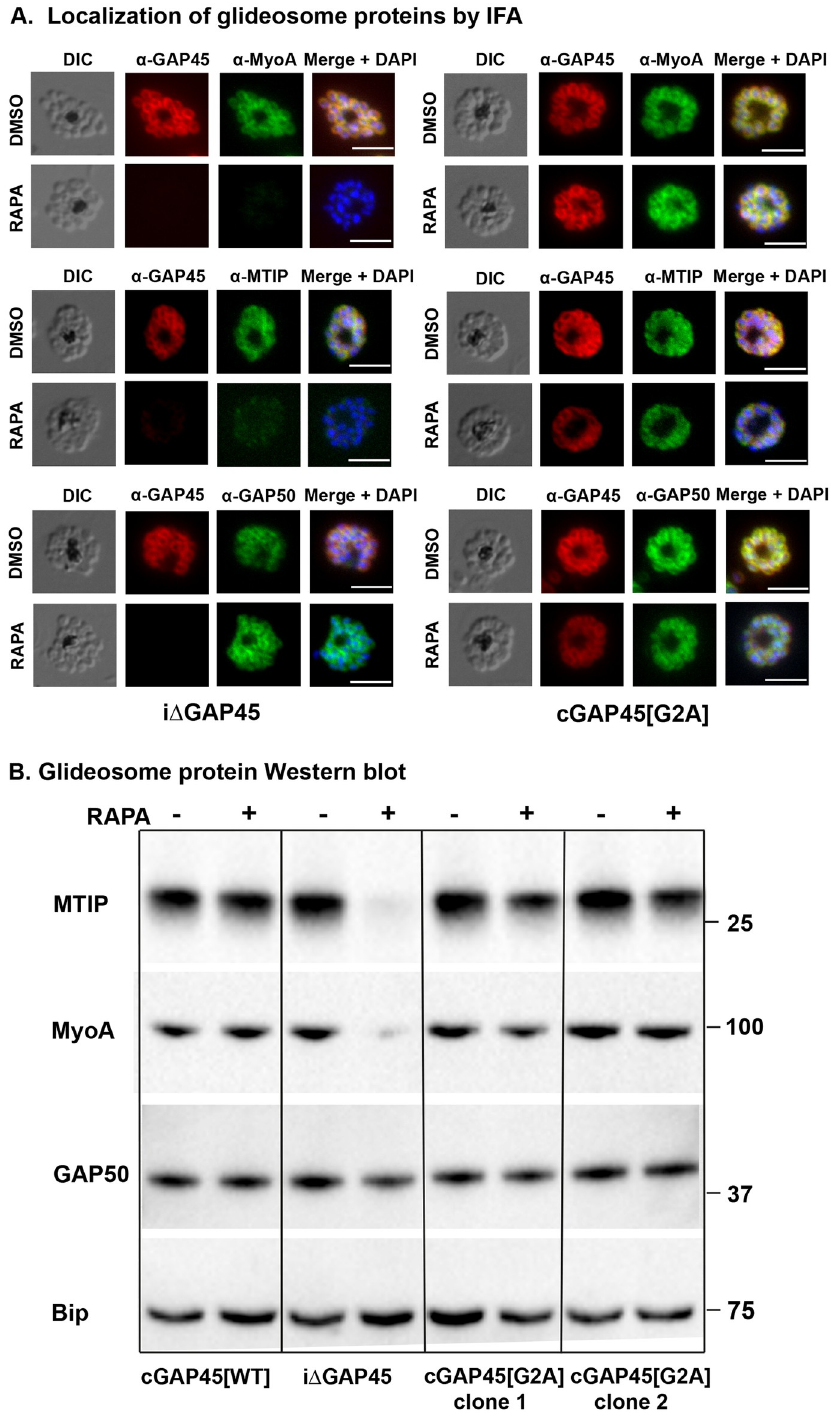
Fig 6. GAP45[G2A] parasites have a correctly localized glideosome. (A) GAP45[G2A] parasites show no defects in expression of the glideosome components MyoA and MTIP and which localized correctly at the periphery of merozoites. IFA showing the subcellular localization of GAP45-HA3, MyoA, MTIP and GAP50 in segmented schizonts of i Δ GAP45 ( gap45 : ha3 : loxP )and cGAP45[G2A] ( gap45 : ha3 : loxP :: comp_gap45[G2A] )in rapamycin and mock-treated (DMSO) parasites. Loss of GAP45 resulted in loss of detection of MTIP and MyoA at the IMC upon rapamycin treatment, while GAP45[G2A] is still able to recruit MTIP and MyoA. GAP50 staining is unchanged